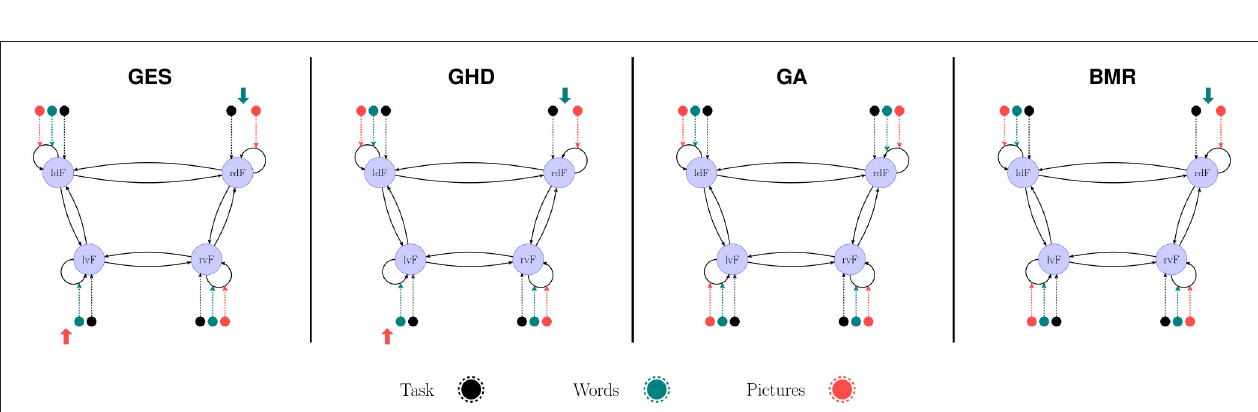
FIGURE 7 | Model search in group-level PEB. The BMR method removed only the modulatory effect of “Words” on the self-inhibition of rdF region. The GES and GHD algorithms also removed the modulatory effect of “Pictures” from lvF self-connection. The GA method found the fully connected model each time regardless of the initial